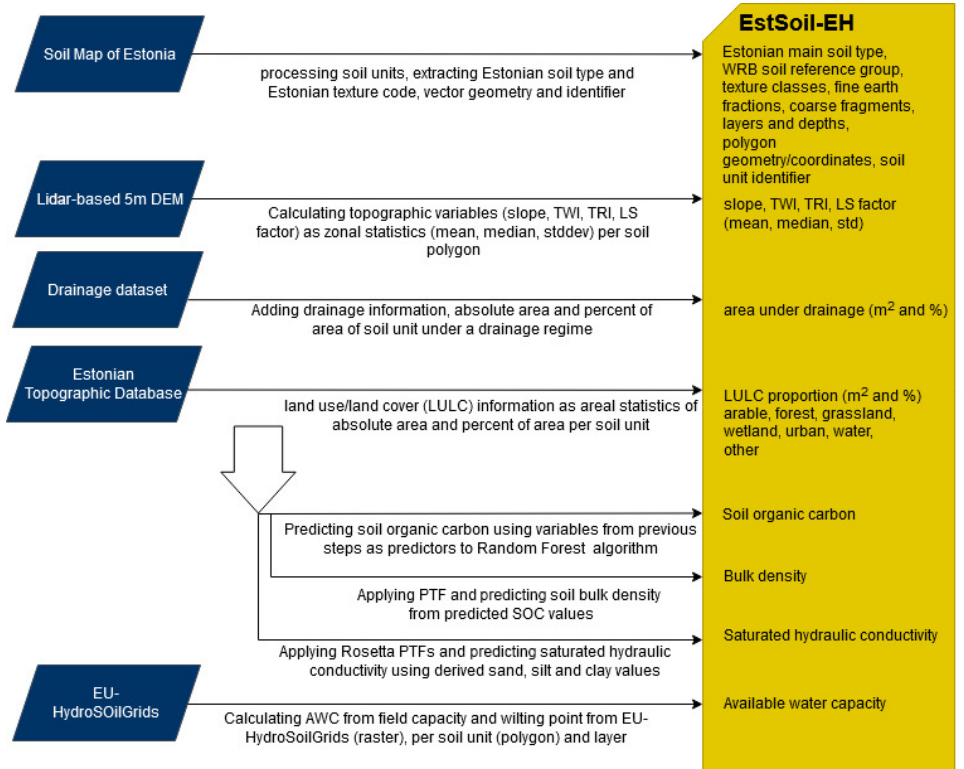
Figure 1. Flowchart for executed processing steps outlining the work packages, input datasets, and derived eco-hydrological modelling parameters on soil, topography, and land